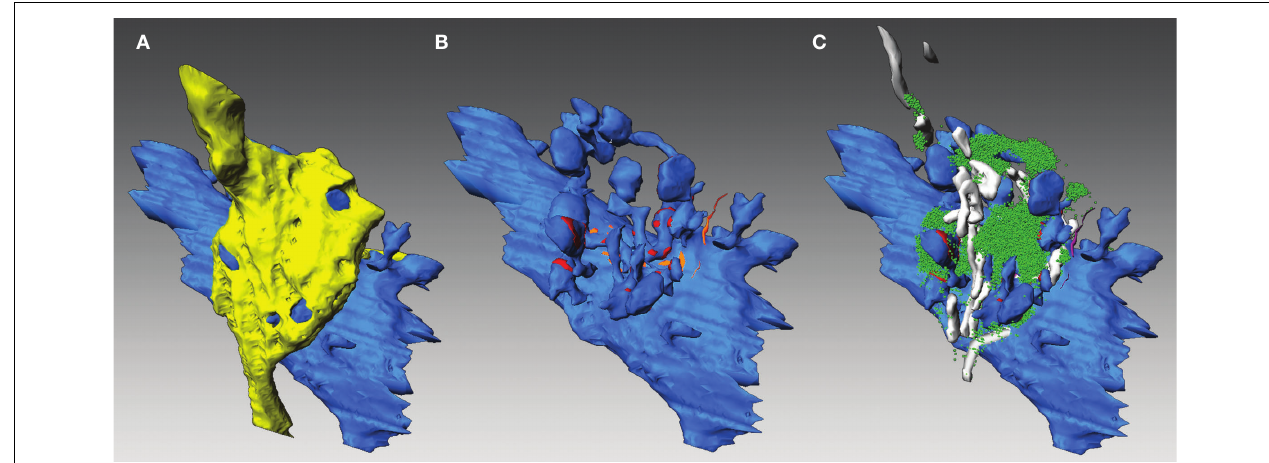
FIGURE 2 | Three-dimensional reconstructions of an adult MFB and its postsynaptic target dendrite. (A) Volume reconstructions of an en passant MFB (depicted in yellow) and its postsynaptic target dendrite (blue). Note, that the spiny excrescences were almost entirely covered by the nerve terminal. (B) Distribution of the two membrane specializations, AZs (in red) and PAs (in orange) on the postsynaptic target dendrite (blue). Note, that AZs